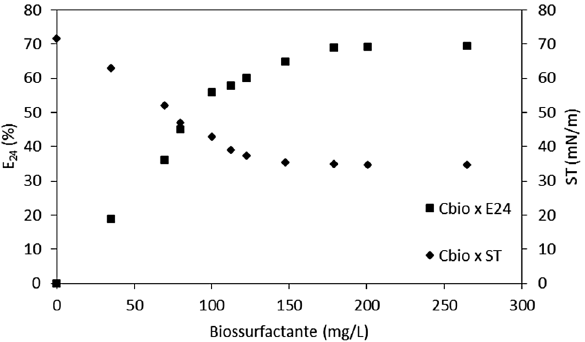
Fig. 3 Emulsification index and surface tension as a function of bio- surfactant concentration